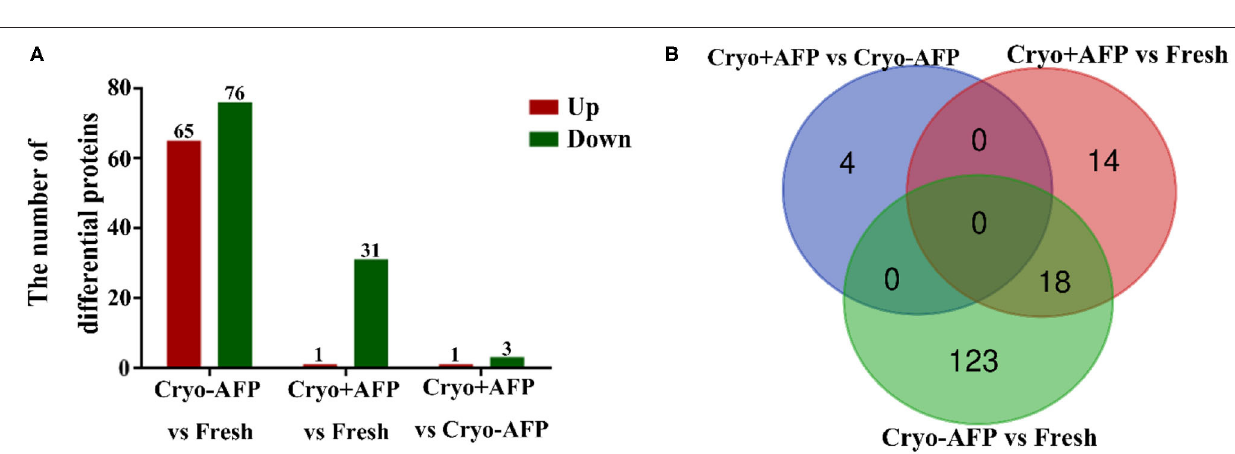
protein), positive regulation of cellular amide metabolic process (GO:0034250, 1 protein), regulation of translation (GO:0006417, 1 protein), and establishment of localization